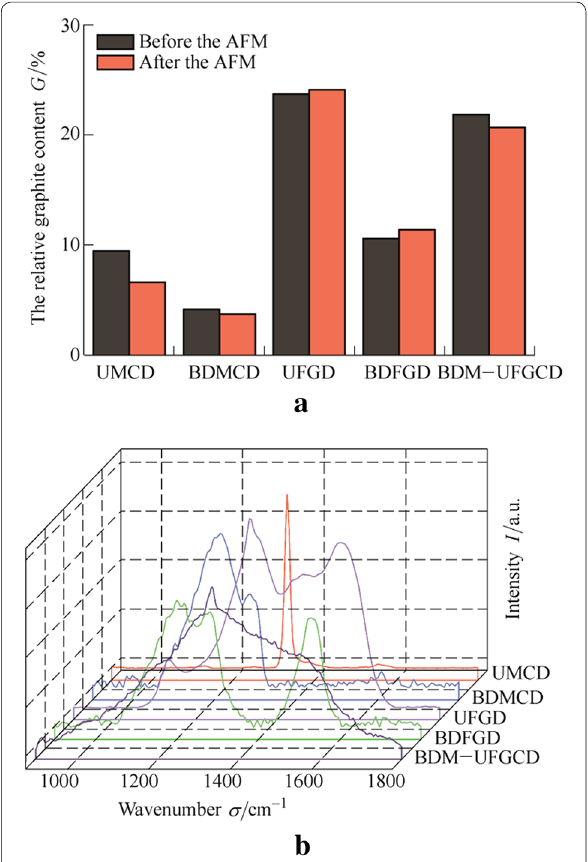
Figure 7 a The relative diamond purity Q of different diamond coated milling cutters before and after AFM processes, and b Raman spectra of specimens after AFM Figure 8 a Original directional cutting force signals for the